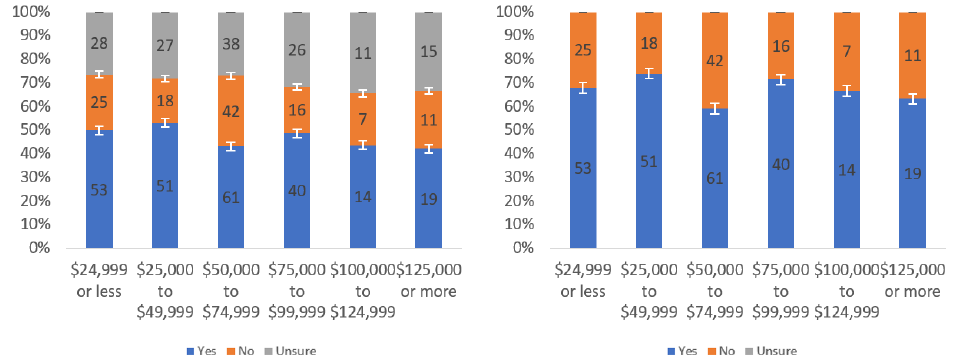
Figure A10. Responses regarding others’ willingness to review by income level including ( left ) and excluding ( right ) unsure responses.